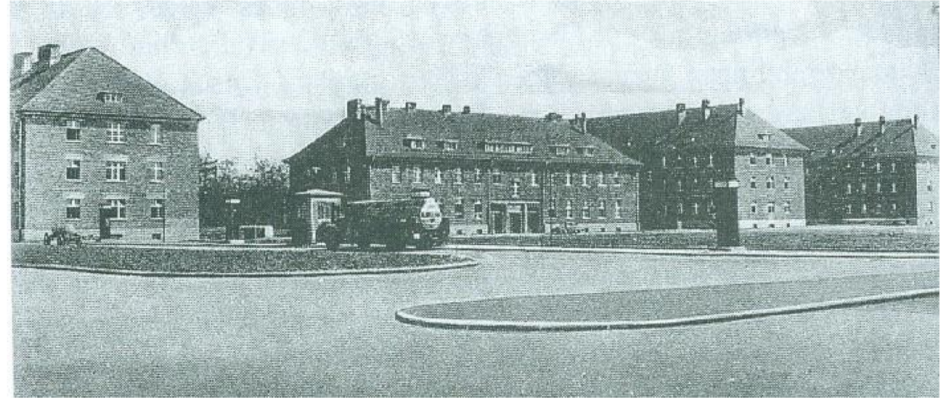
Figure 8. The original view of Kasernen Siegeshöhe (source